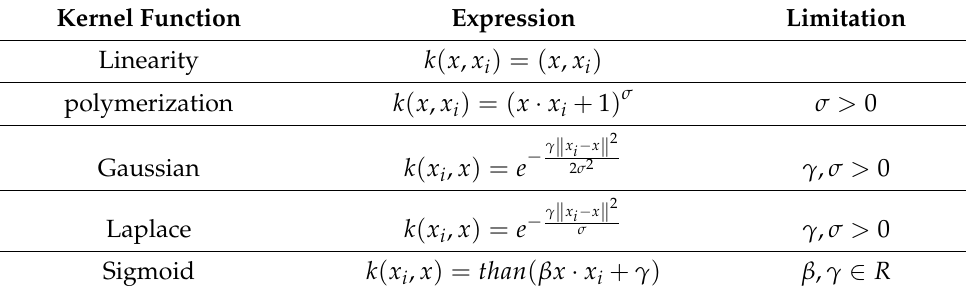
Table 1. Kernel function in